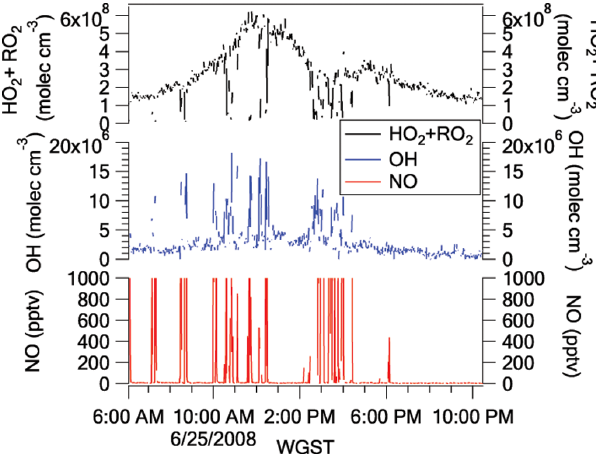
Fig. 3. An example of elevated OH and depleted HO 2 +RO 2 at high NO conditions. The spikes in NO and the responses in OH and HO 2 +RO 2 are due to the measurement cite being impacted by the plume of the